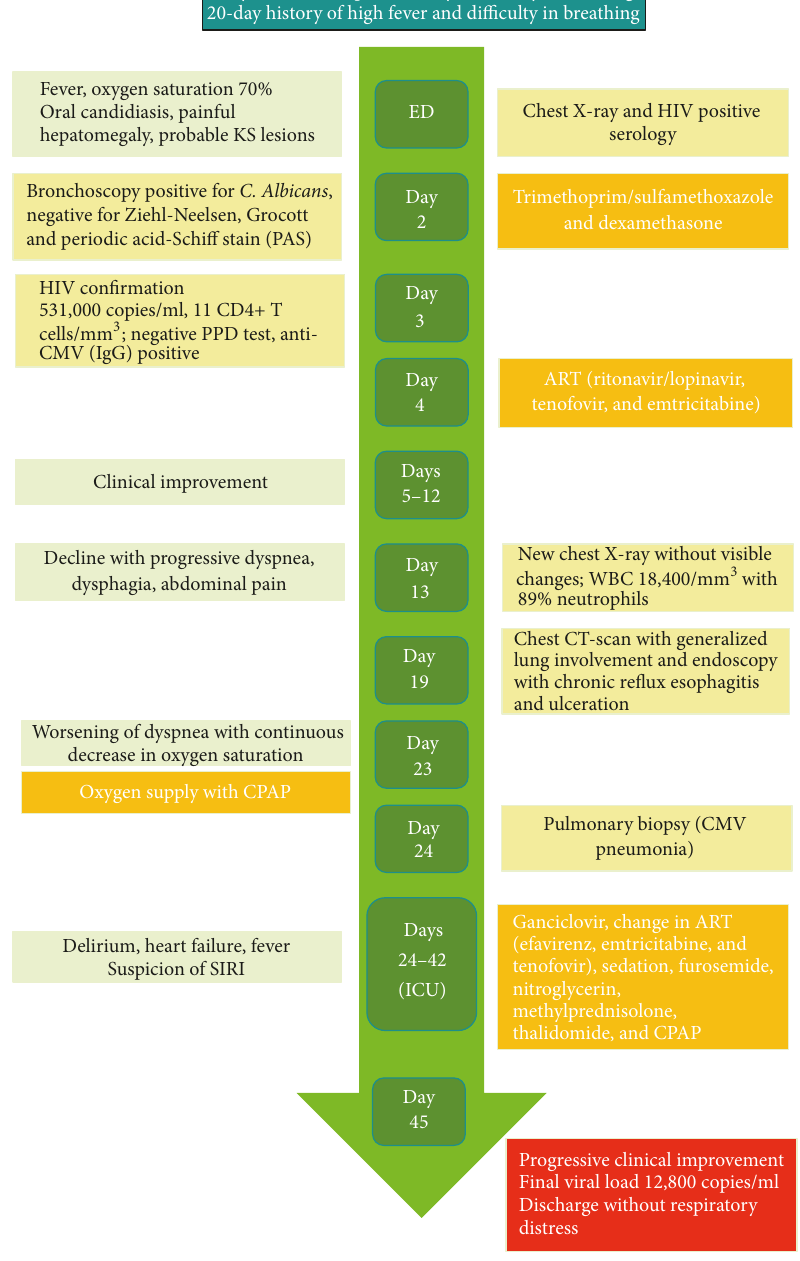
Figure 3: Timeline of patients’ clinical evolution with diagnostic tests and treatments. HIV human immunodeficiency virus, KS Kaposi’s sarcoma, PPD purified protein derivative, CMV cytomegalovirus, ART antiretroviral therapy, CPAP continuous positive airway pressure, and IRIS immune reconstitution inflammatory